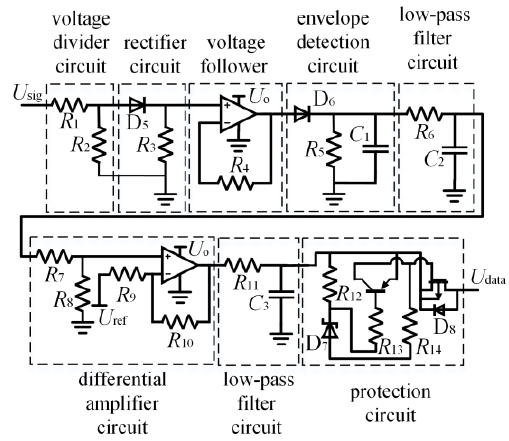
Figure 6. Demodulation circuit